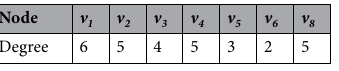
Table 1. Degree of v 1 and adjacent nodes.